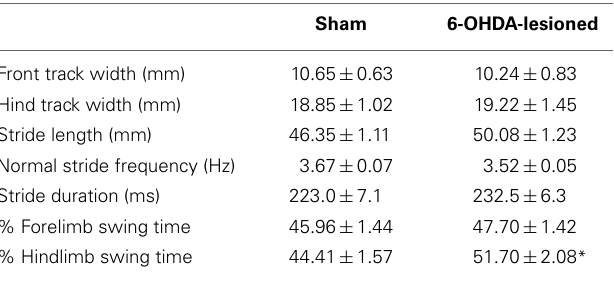
Table 1 | Summary of gait parameters in sham and 6-OHDA-lesioned